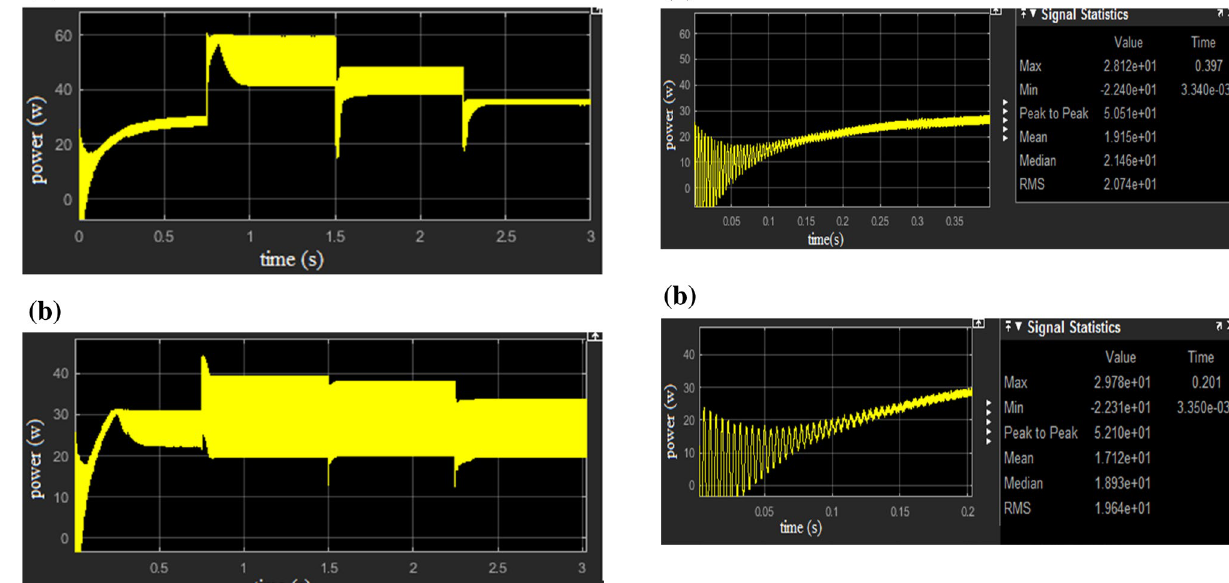
Fig. 9 a Power signal expanded at startup (Conventional MPPT). b Power signal expanded at startup (thermography MPPT)